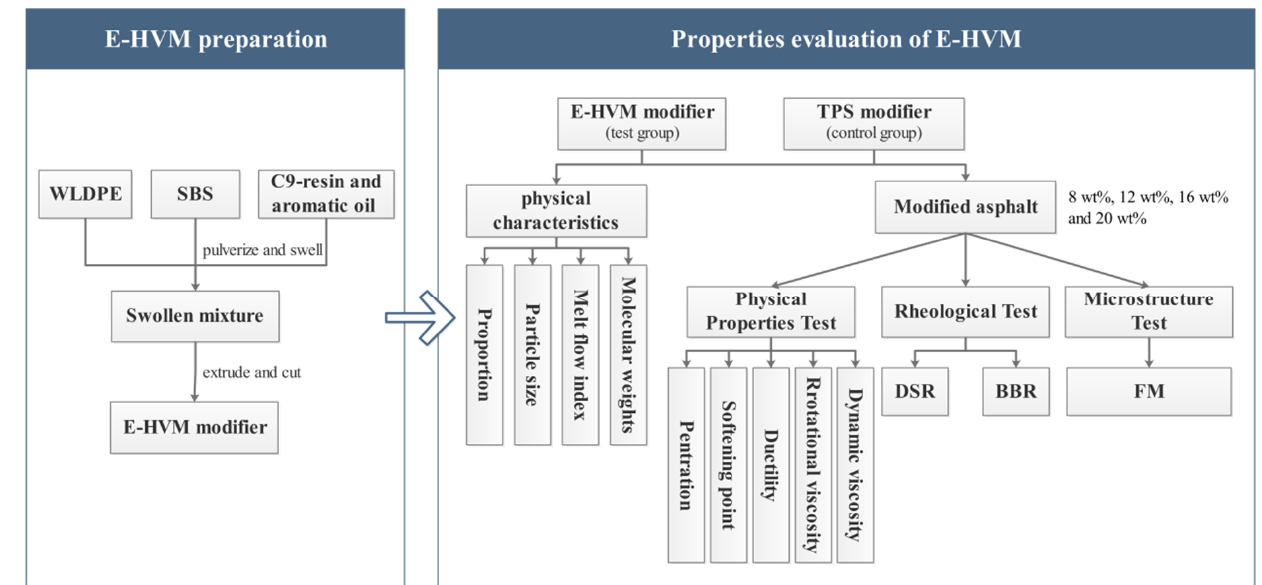
Figure 1. Flowchart of experimental plan procedure in this study.